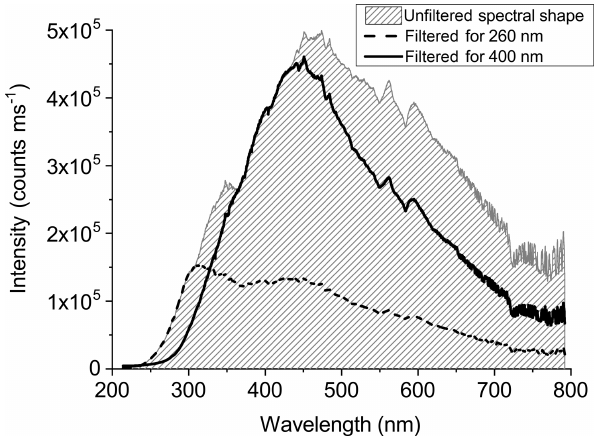
Figure 6. Comparison of lamp spectra with the position of the fi- bre entrance optimized for 260nm (dashed line) and 400nm (drawn line). For comparison, a modelled spectral distribution of the light source unaltered by the chromatic aberration of the lens is also shown (shaded area). The latter was obtained by varying the fibre position through all foci from 200 to 800nm and taking the enve- lope of the resulting